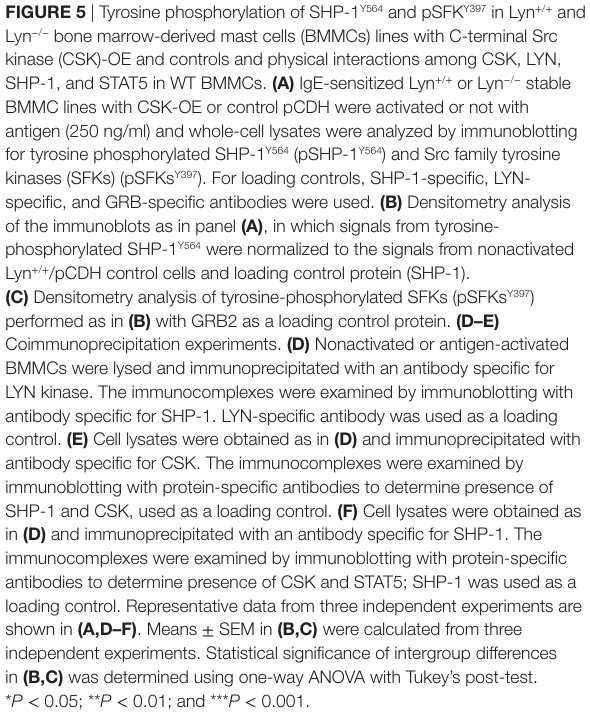
FigUre 5 | Tyrosine phosphorylation of SHP-1 Y564 and pSFK Y397 in Lyn + / + and Lyn − / − bone marrow-derived mast cells (BMMCs) lines with C-terminal Src kinase (CSK)-OE and controls and physical interactions among CSK, LYN, SHP-1, and STAT5 in WT BMMCs. (a) IgE-sensitized Lyn + / + or Lyn − / − stable BMMC lines with CSK-OE or control pCDH were activated or not with antigen (250 ng/ml) and whole-cell lysates were analyzed by immunoblotting for tyrosine phosphorylated SHP-1 Y564 (pSHP-1 Y564 ) and Src family tyrosine kinases (SFKs) (pSFKs Y397 ). For loading controls, SHP-1-specific, LYN- specific, and GRB-specific antibodies were used. (B) Densitometry analysis of the immunoblots as in panel (a) , in which signals from tyrosine- phosphorylated SHP-1 Y564 were normalized to the signals from nonactivated Lyn + / + /pCDH control cells and loading control protein (SHP-1). (c) Densitometry analysis of tyrosine-phosphorylated SFKs (pSFKs Y397 ) performed as in (B) with GRB2 as a loading control protein. (D–e) Coimmunoprecipitation experiments. (D) Nonactivated or antigen-activated BMMCs were lysed and immunoprecipitated with an antibody specific for LYN kinase. The immunocomplexes were examined by immunoblotting with antibody specific for SHP-1. LYN-specific antibody was used as a